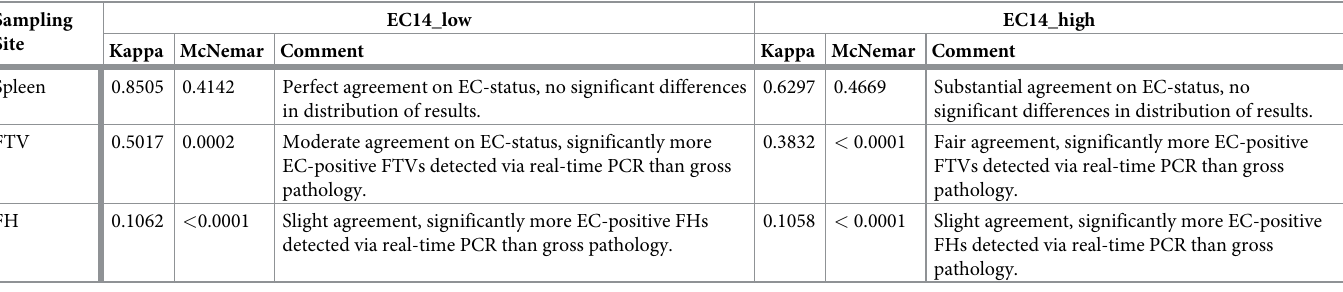
Table 2. Kappa coefficient and McNemar’s test for comparison of different detection